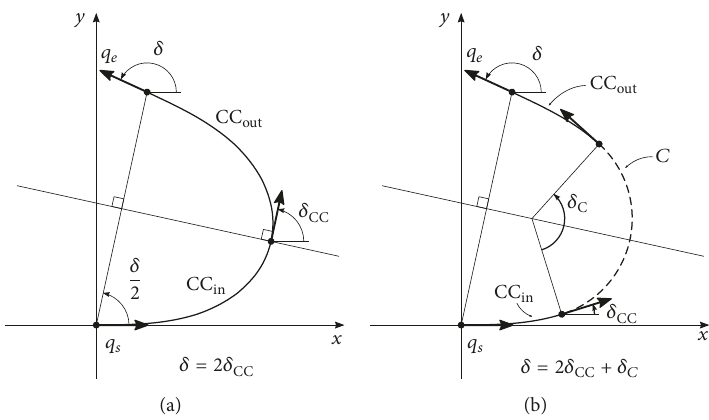
Figure 3: Structure of (a) elementary paths and (b)